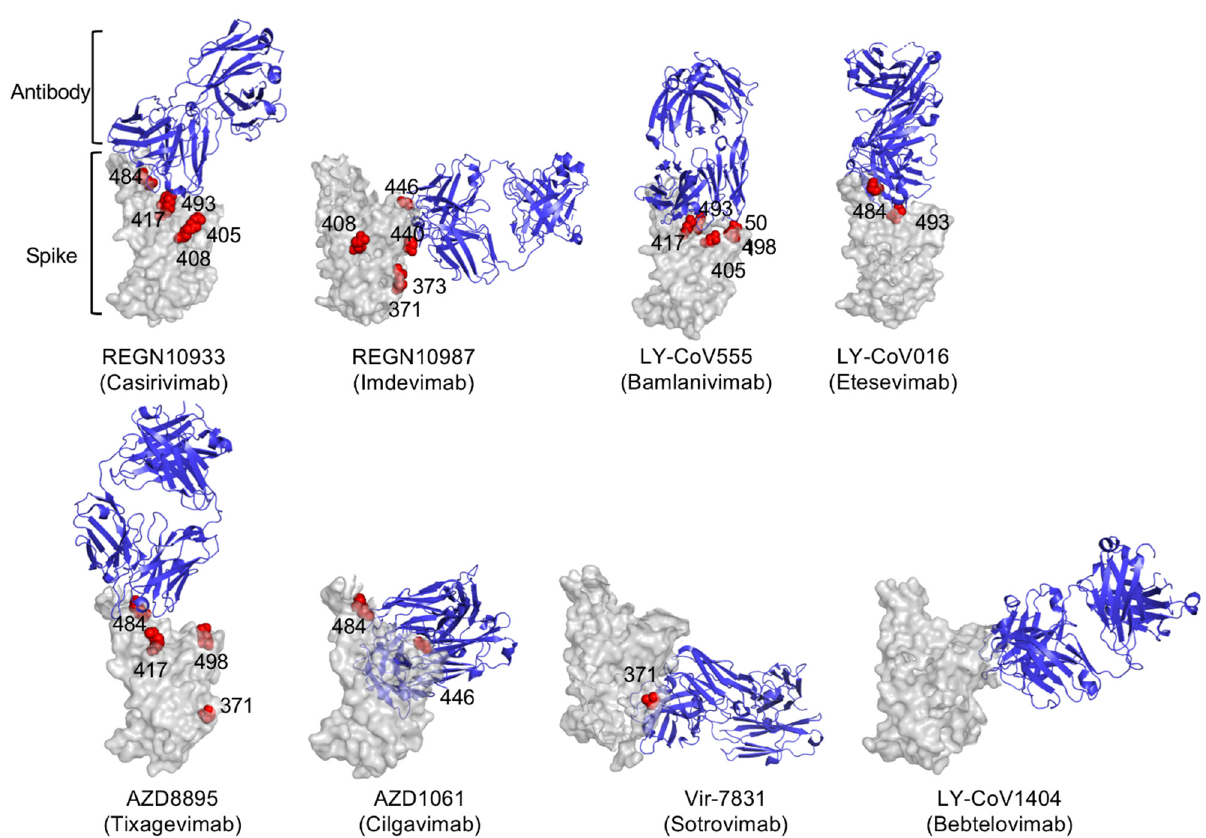
Figure 4. The location of mutations that affect monoclonal antibody binding is shown on the antibody:spike protein complex. Complexes were visualized with PyMOL Molecular Graphics System, v2.1.1 (Schrödinger, LLC) software. Mutations in BA.1 that are also in BA.2 previously reported [12,22,23] to have >5-fold effect on neutralizing titer are shown in red.